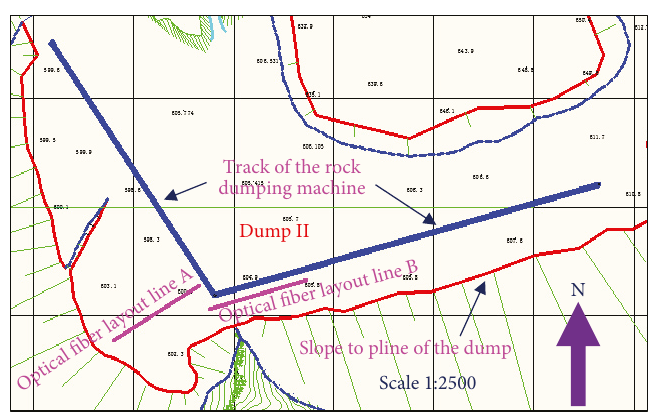
Figure 25: Optical fi ber layout map of dump deformation monitoring.